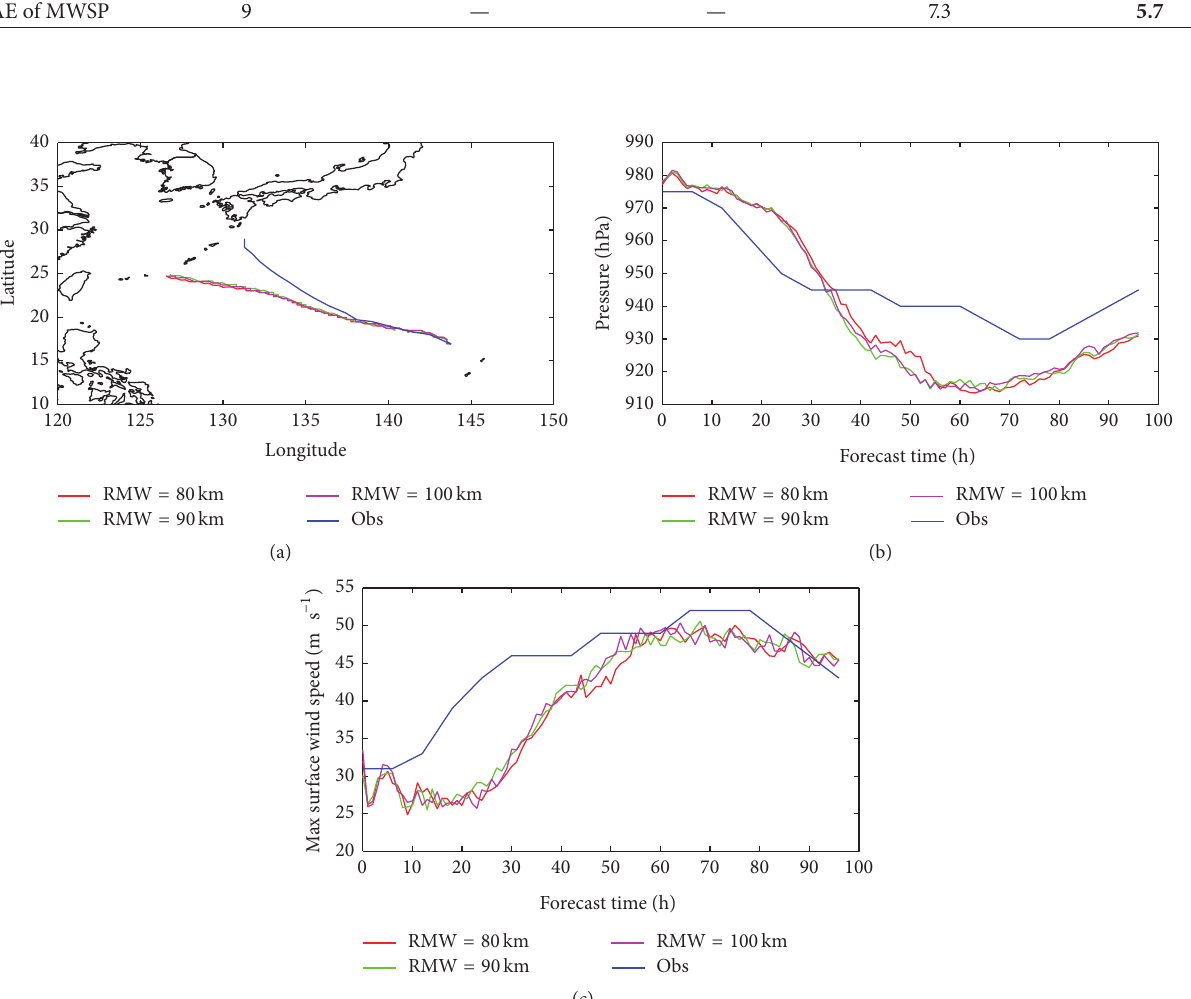
Figure 6: Phanfone: simulation results with RMW = 80, 90 and 100km (a) track; (b) CSLP; (c)